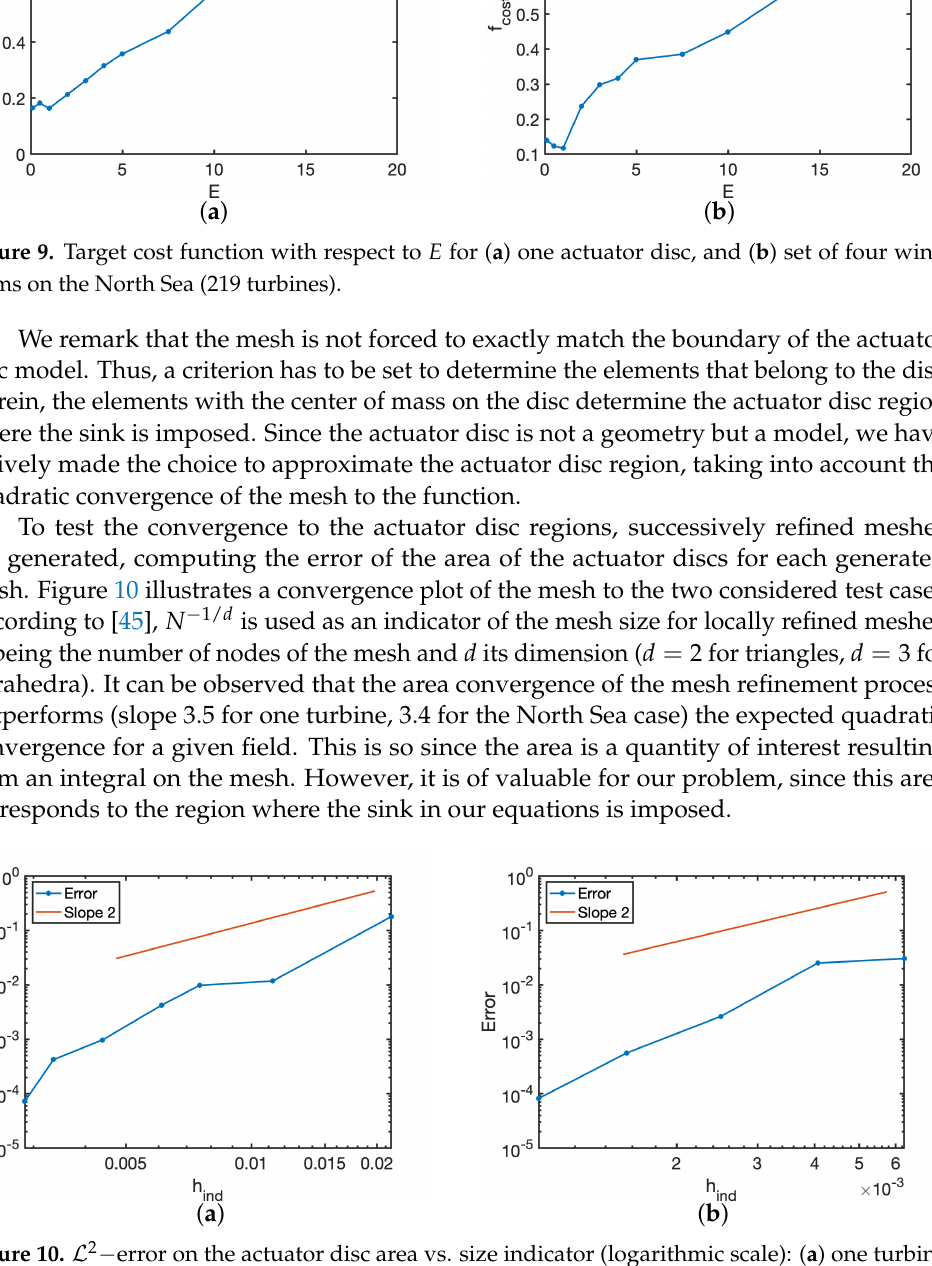
Figure 10. L 2 − error on the actuator disc area vs. size indicator (logarithmic scale): ( a ) one turbine and ( b ) set of 4 wind farms on the North